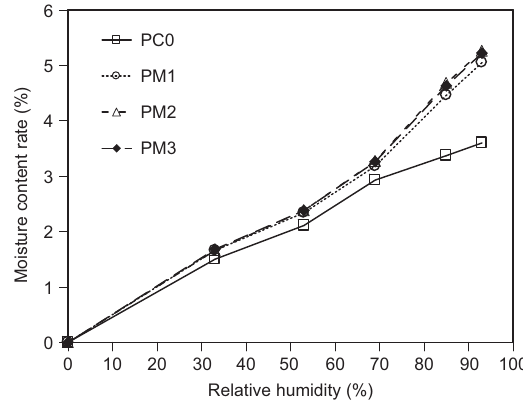
Figure 4 Initial surface absorption of cement pastes vs. the mont- morillonite contents.